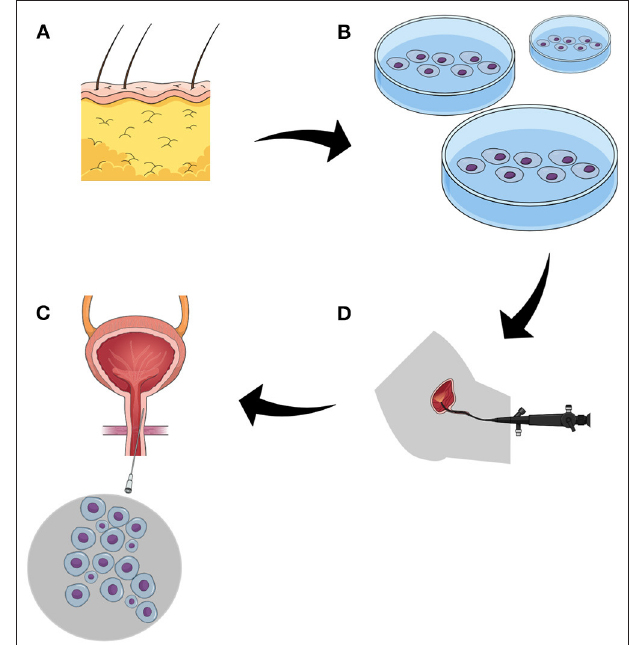
FIGURE 1 | The figure demonstrates the strategy of cell-based approach to postprostatectomy stress urinary incontinence. (A) adipose tissue, the source of mesenchymal stem cells. (B) isolated stem cells underwent purification and propagation in vitro . (C) the function of the sphincter is evaluated endoscopically, the most common approach utilizes flexible urethroscopy. (D) administration of stem cells to sphincter complex by targeted multiple